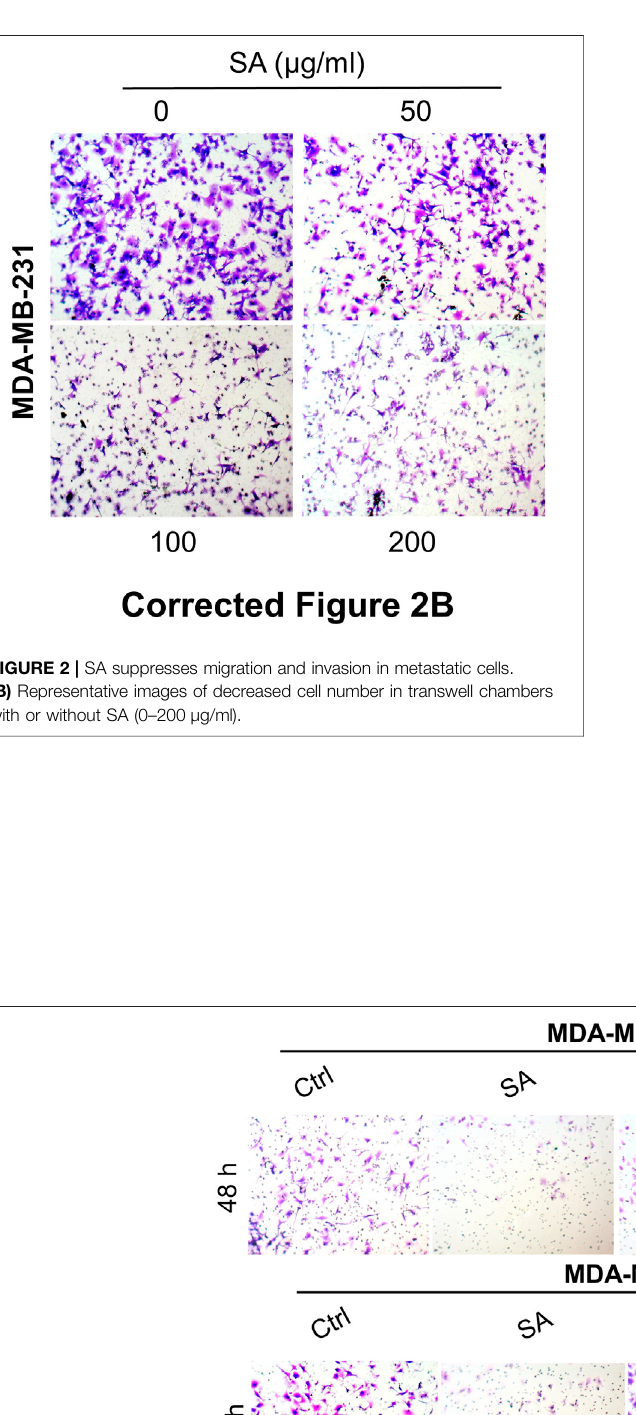
Frontiers in Pharmacology |